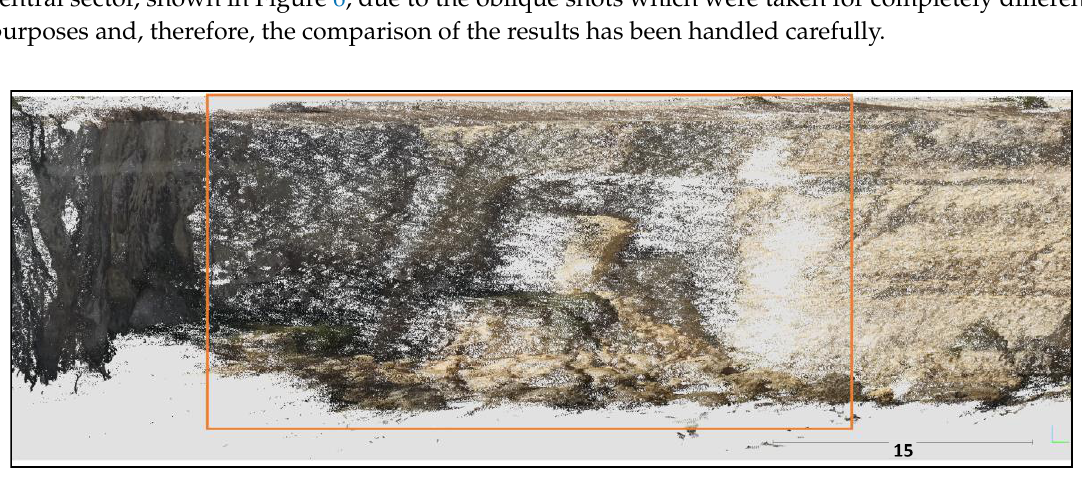
Figure 6. Artifacts in the central sector of R17, results from this sector were considered not reliable and thus excluded.